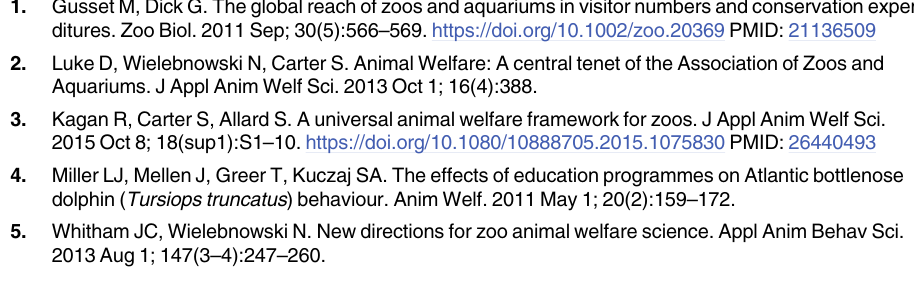
S1 Fig. Striking image lauderdale